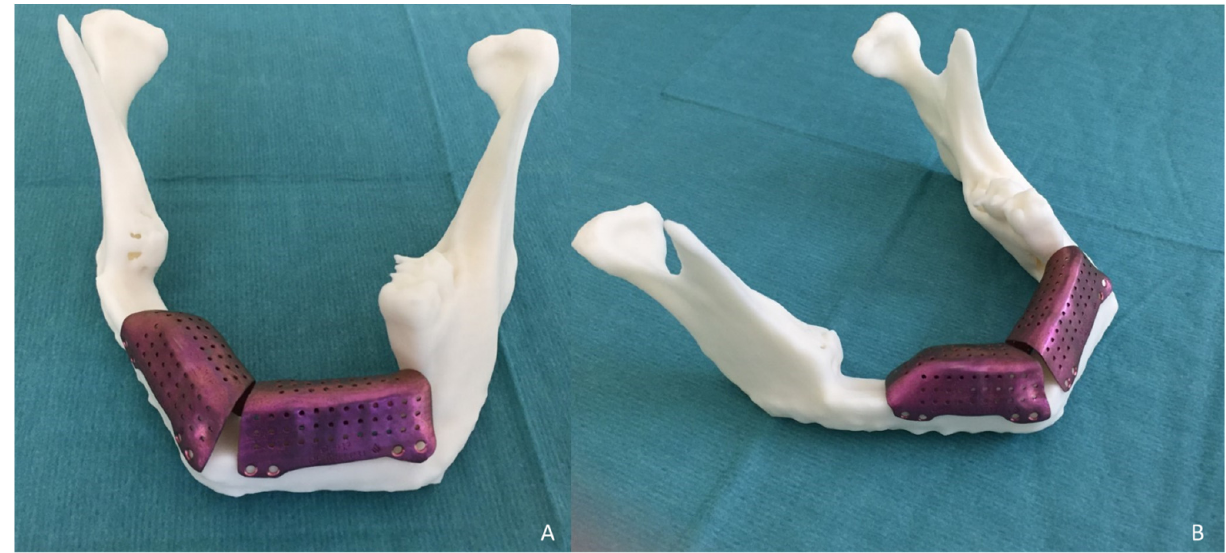
Figure 4. ( A ) and ( B ) Stereolithographic model (STL) showing the vertical bone discrepancy and the adaptation of CAD/CAM titanium mesh to the fibula for three-dimensional bone reconstruction.